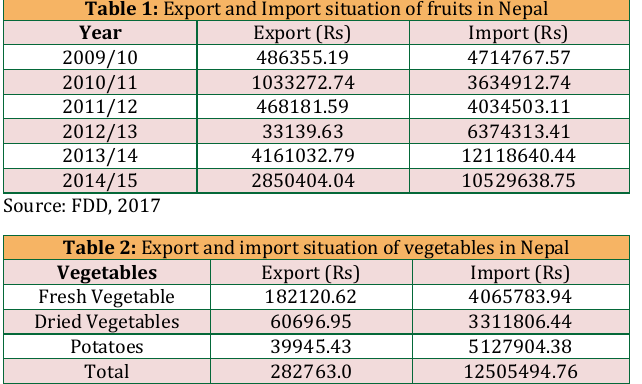
Table 1: Export and Import situation of fruits in Nepal Year